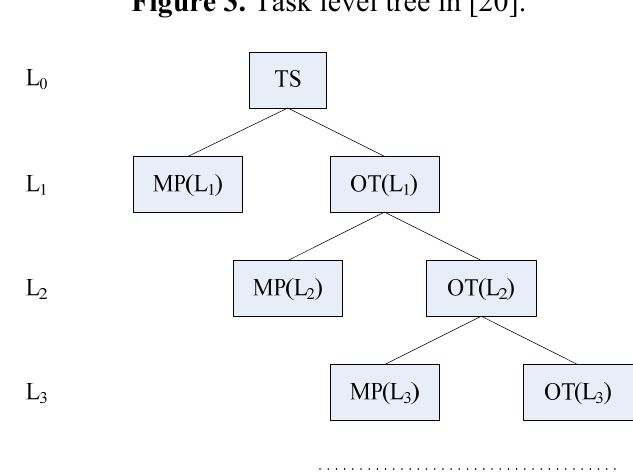
Figure 3. Task level tree in